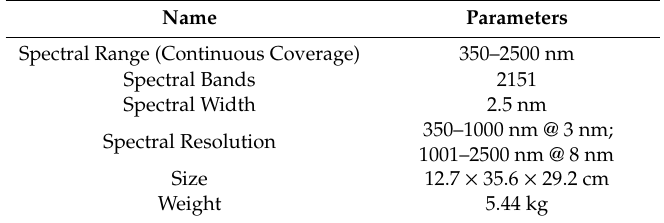
Table 2. Parameters of the Analytical Spectral Device (ASD) FieldSpec4 portable